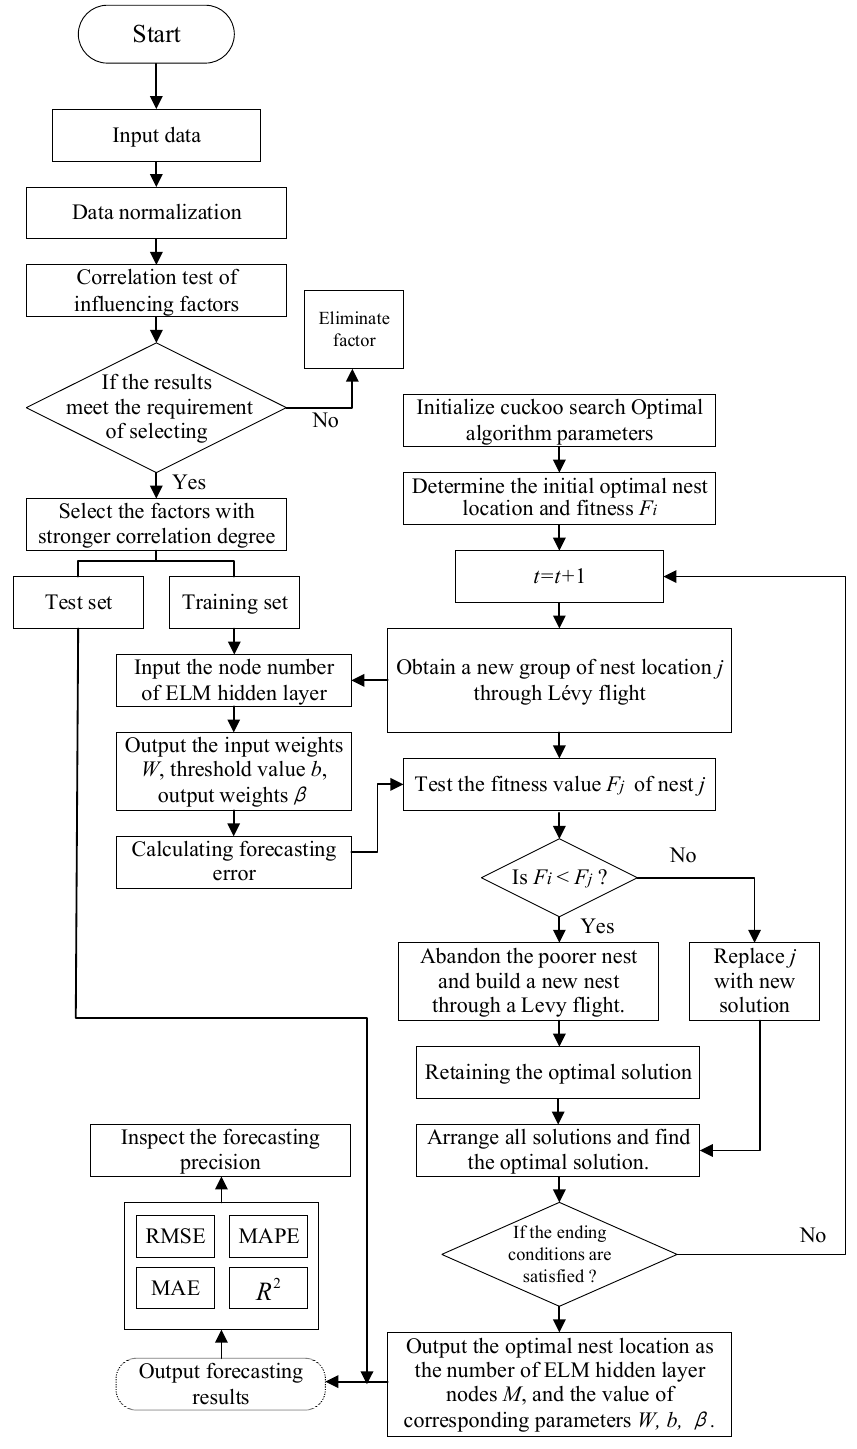
Figure 1. Outline of procedure of proposed method.